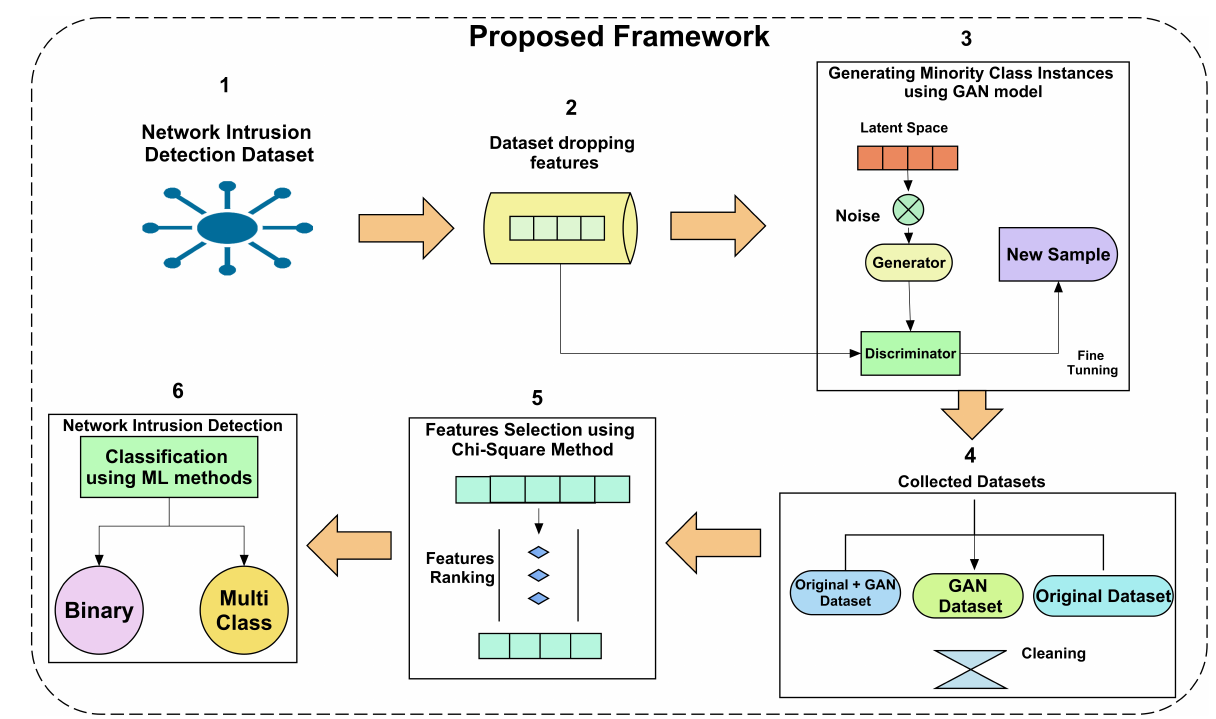
Figure 1. Proposed framework containing steps to make balanced data-based improved